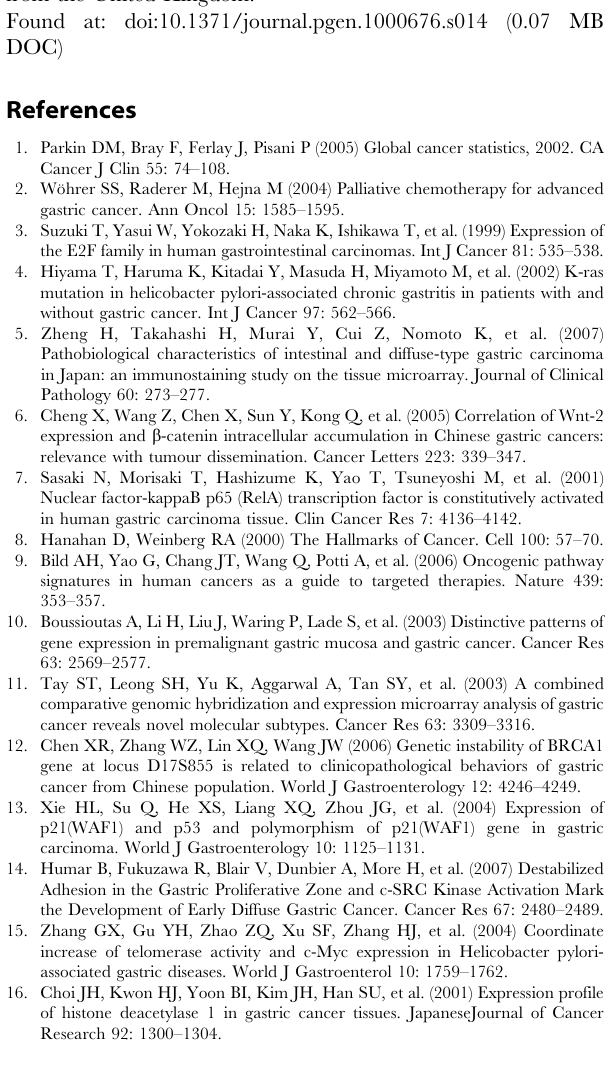
Table S6 Multivariate analysis for tumor stage (TNM classifi- cation) and combined activation levels of proliferation/stem cell and NF- k B pathways in primary tumors. Table S7 Multivariate analysis for tumor stage (TNM classifi- cation) and combined activation levels of proliferation/stem cell and Wnt/ b -catenin pathways in primary tumors.